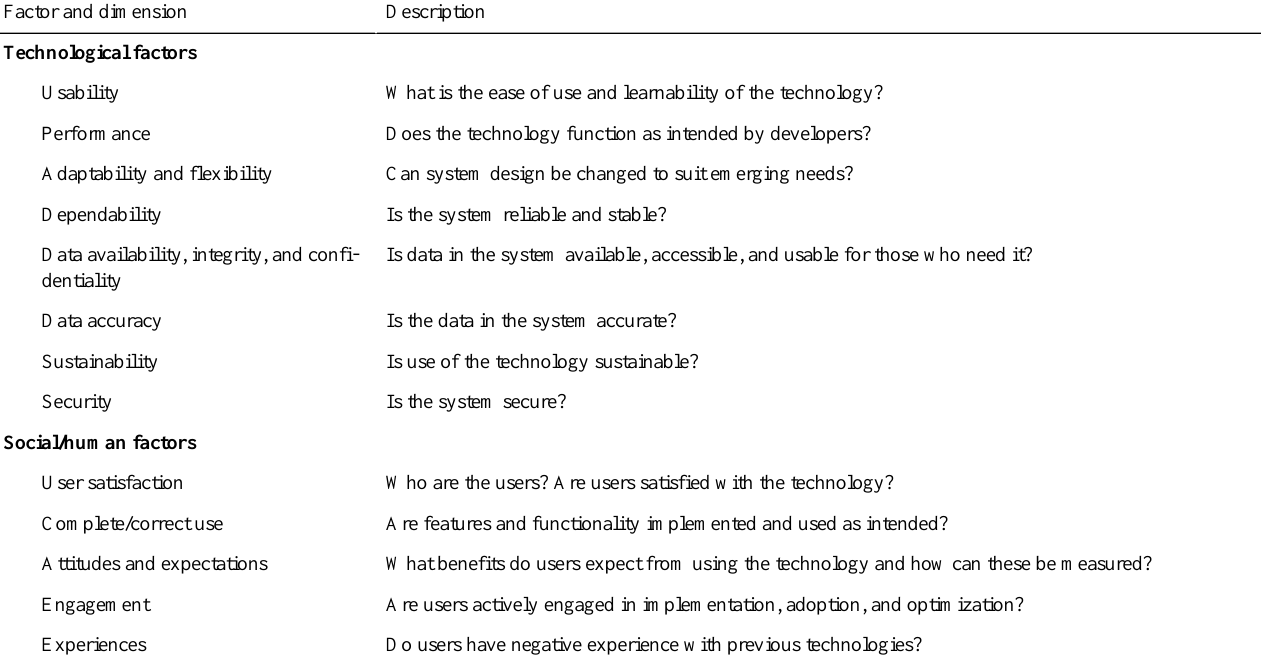
Table 3. The Technology, People, Organizations, and Macroenvironmental factors (TPOM) framework, with example descriptions of dimensions. DescriptionFactor and